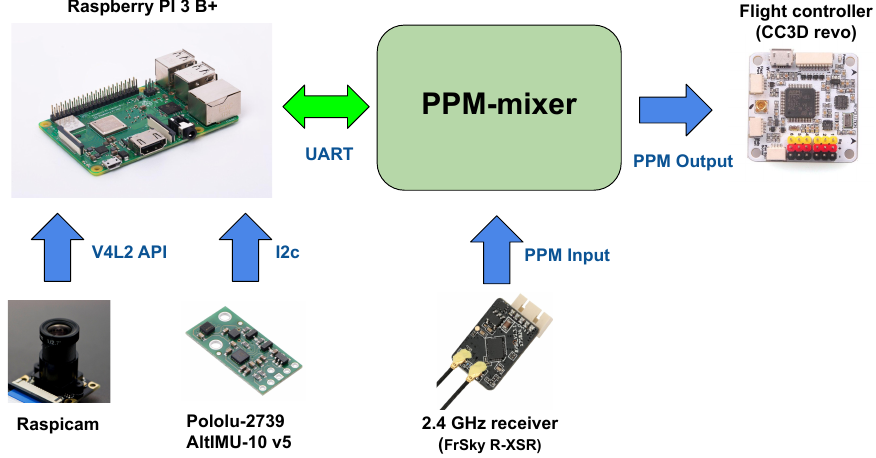
Figure 2. Hardware configuration and dependencies. The PPM-mixer board is an interface between the low-level flight controller and a Raspberry PI board, on which the high-level navigation software is